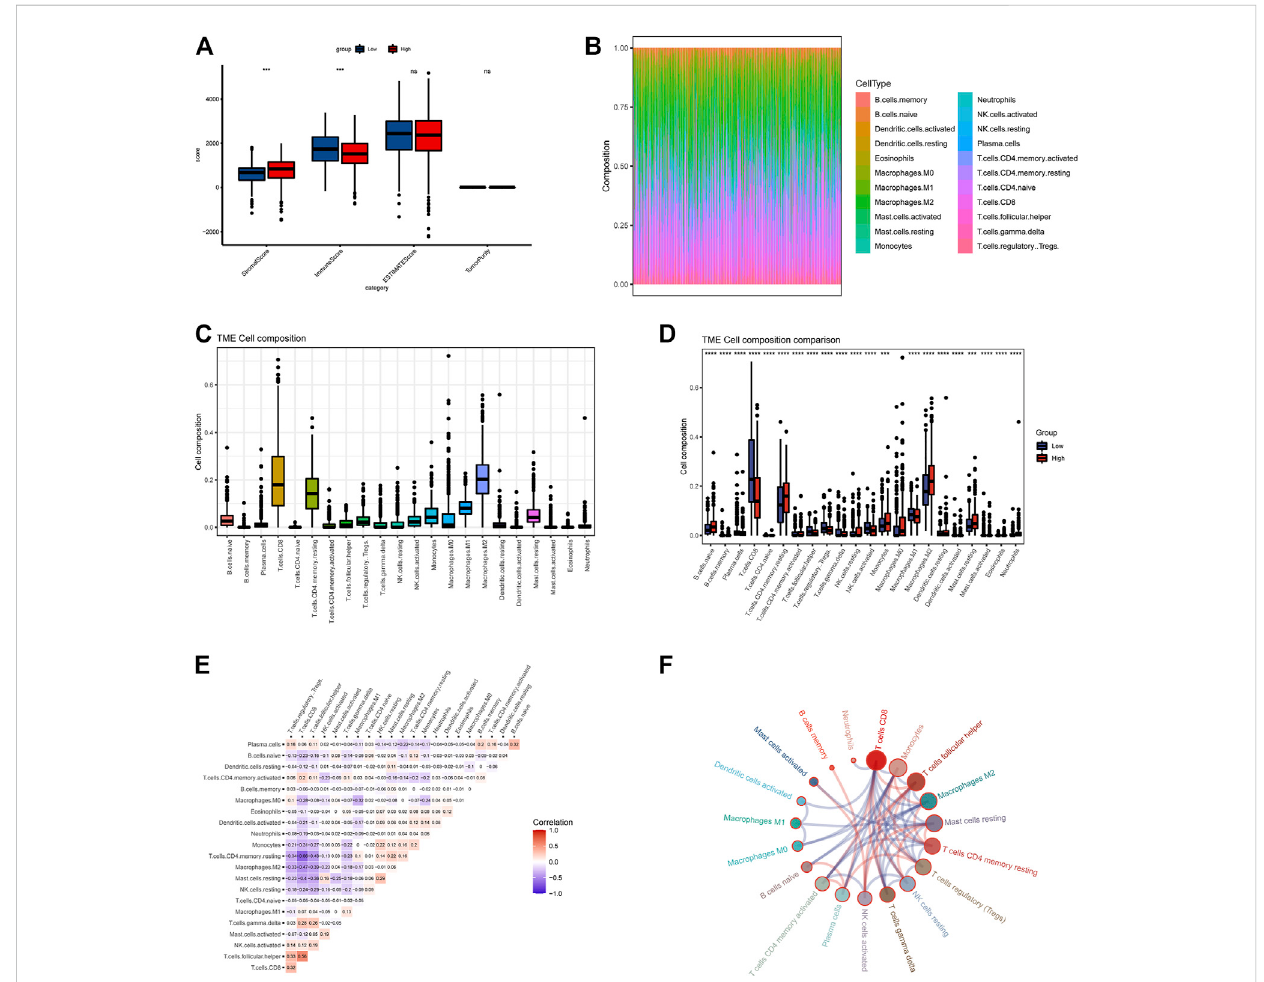
FIGURE 4 Evaluation of immune cell matrix and abundance of 534 TCGA tumor samples. (A) ssGSEA demonstrates differences in immune matrix scores between two groups. (B,C) Immune cells components between two groups by CIBERSORT method. (D) Differences in immune cell expression values between two groups. (E,F) The correlation between immune cells, all samples with a p -value of < 0.05 were included. Red color means positive correlation, and blue represents negative